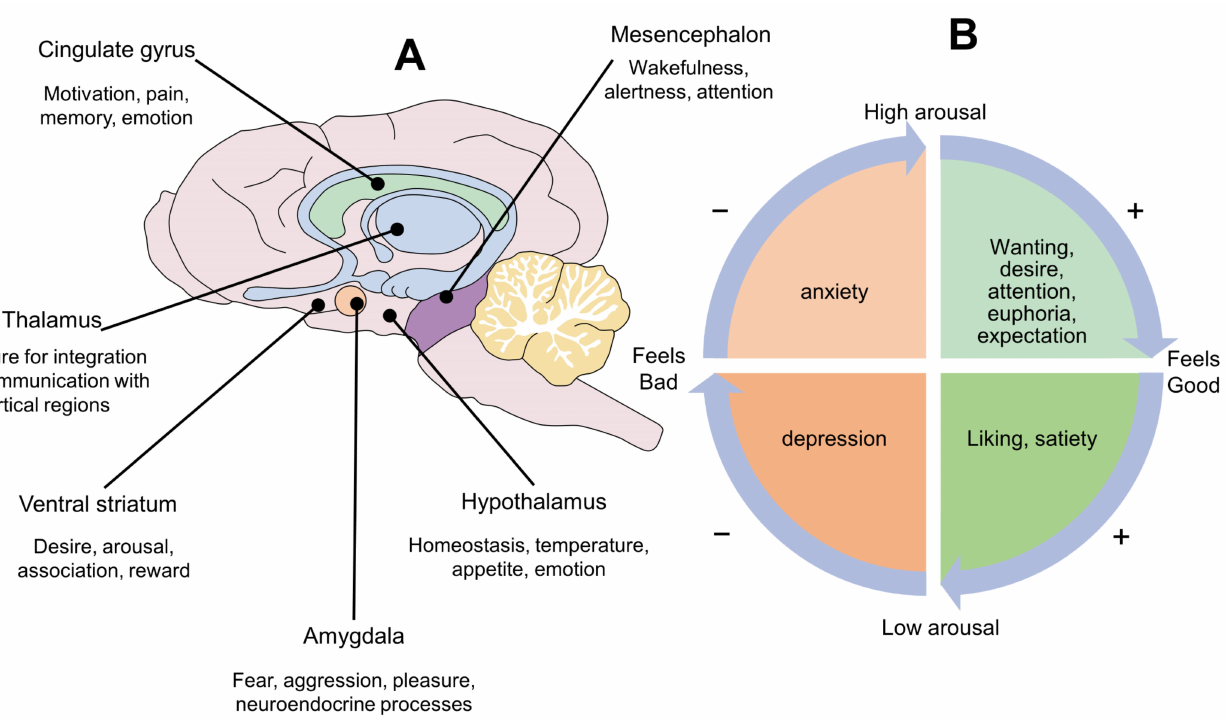
Figure 2. ( A ) Schematization and function of the limbic system in subcortical areas of the brain. Sagittal view of a dog’s brain (midline) indicating the main sub-cortical structures that mediate